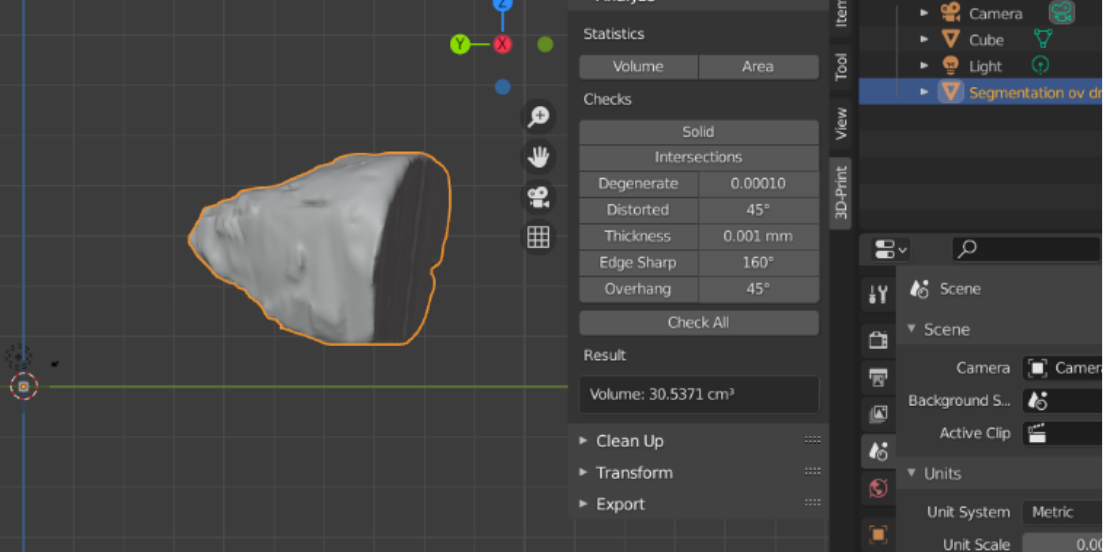
Figure 4. The volume of bony orbit in cm 3 .